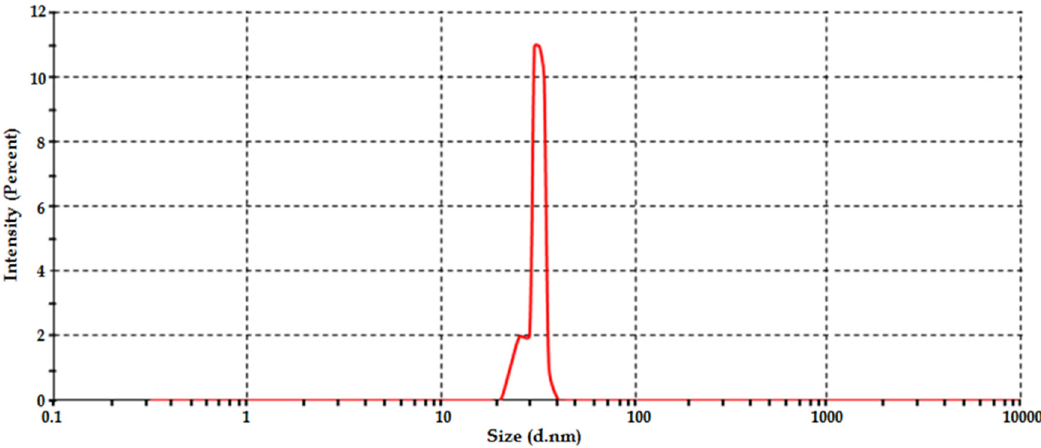
Figure 3. particle size distribution Sample 23 .